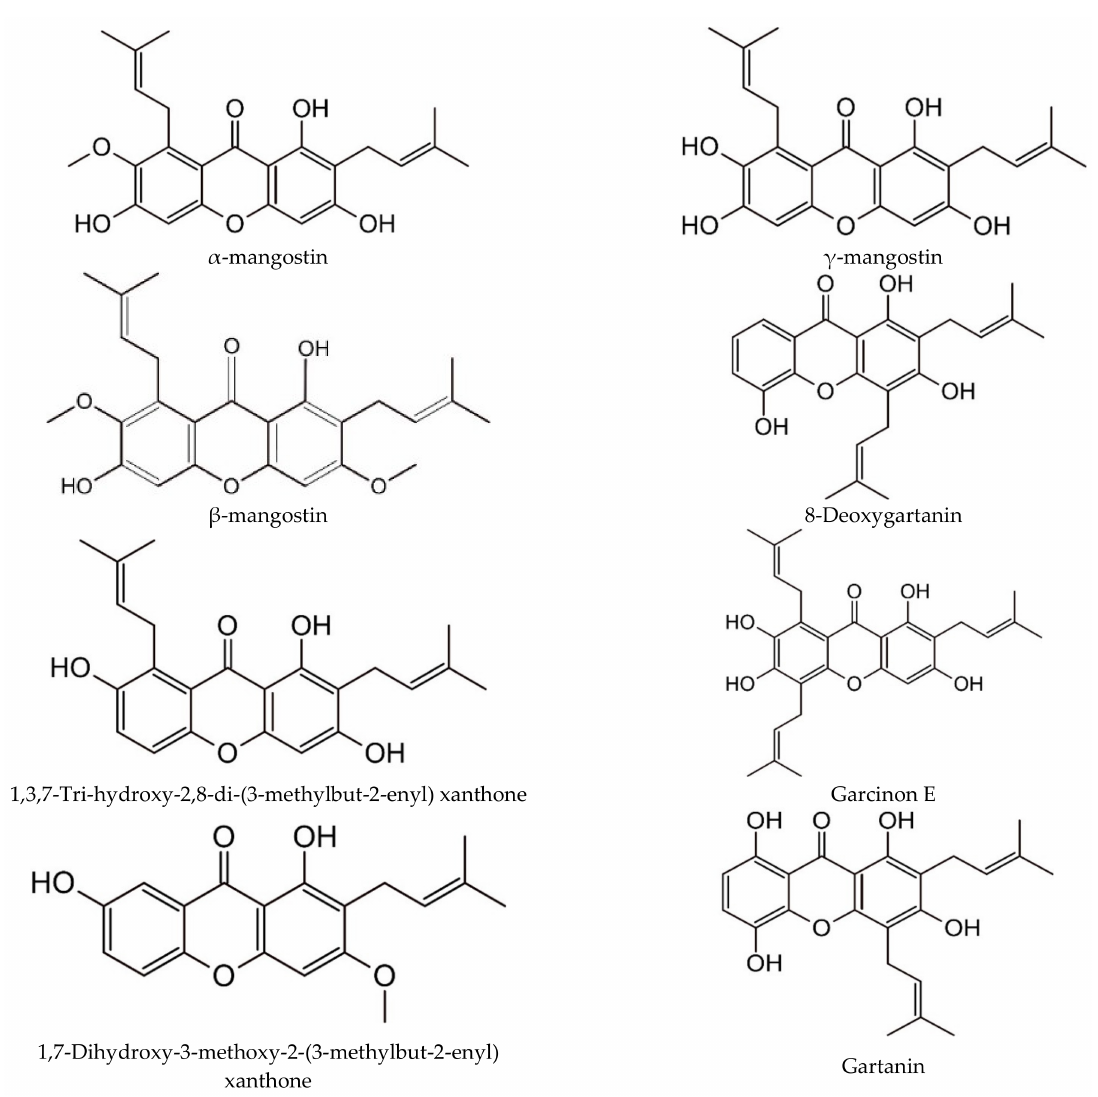
Figure 3. Chemical structure of major and minor xanthone